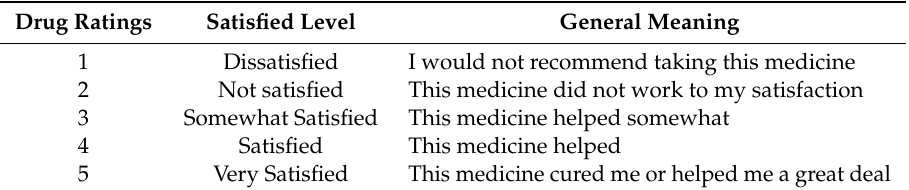
Table 1. Review Rating for AskaPatient.com.